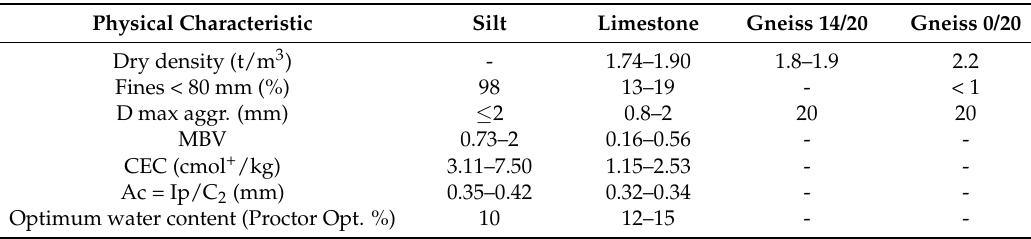
Table 1. Physical characteristics of the filling